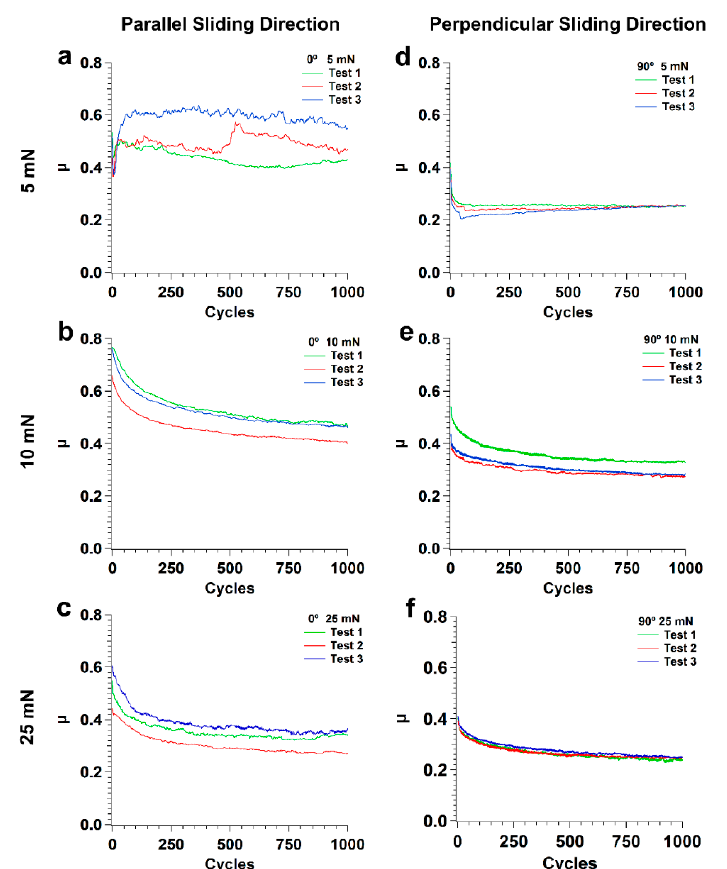
Figure 3. Variation of the friction coefficient with the number of cycles (proportional to the sliding distance) of three consecutive tests performed on textured specimen sliding in the parallel (0°) direction at ( a ) 5, ( b ) 10 and ( c ) 25 mN, and in the perpendicular (90°) direction at ( d ) 5, ( e ) 10 and ( f ) 25 mN.